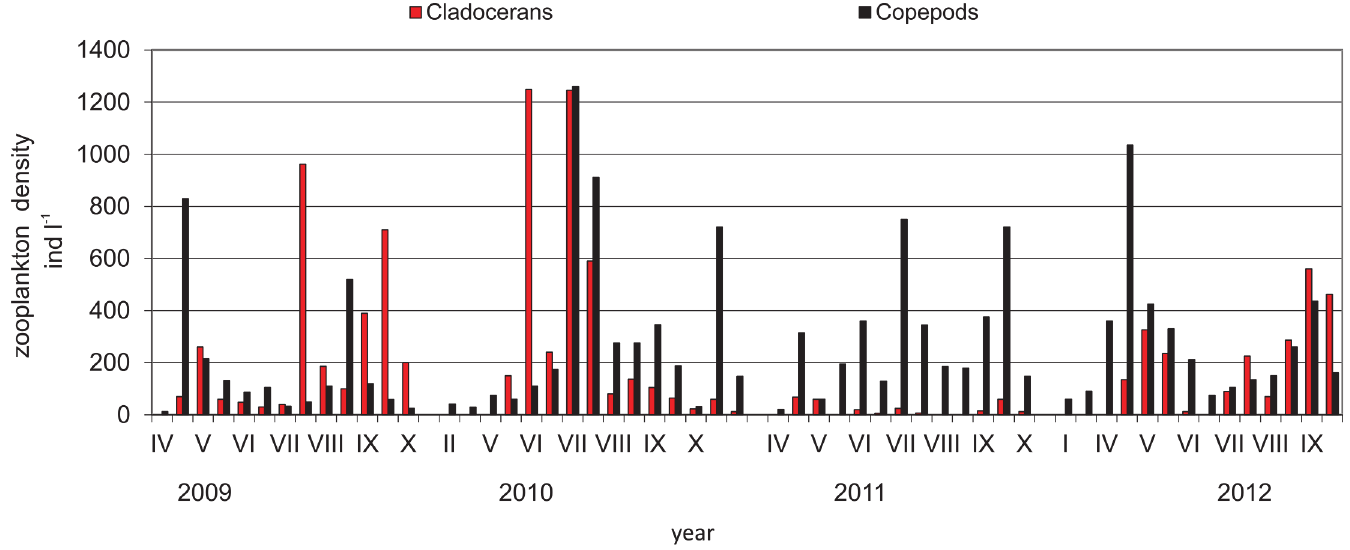
Fig 9. The abundance of cladocerans and copepods (an example from the depth of 2 m).